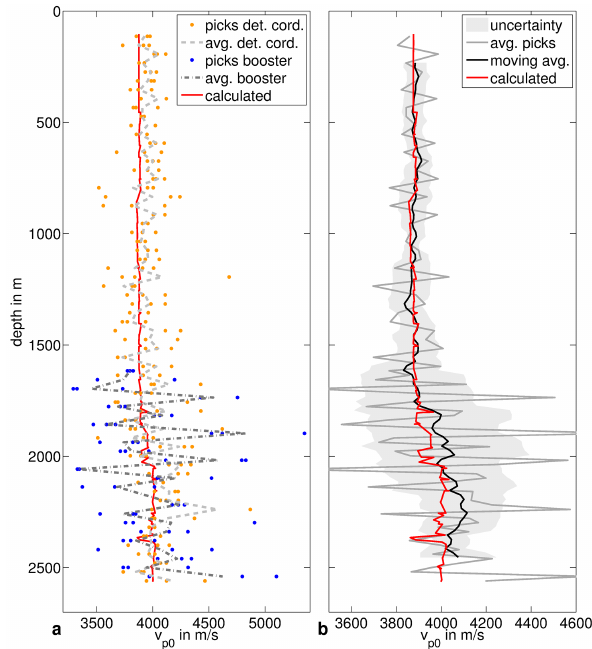
Figure 6. (a) The picked interval velocities for first break, maxi- mum and zero crossing picked from the detonation cord survey (or- ange dots) and the booster survey (blue dots) with the correspond- ing average, dashed light-grey line (detonation cord) and dashed- dotted line (booster). (b) Average interval velocity (grey line) de- rived from the travel times of the detonation cord and booster survey for the three different picks (first break, maximum, zero crossing). The black line shows the moving average with a sliding window of 200m and its rms error (grey area). These interval velocities are temperature-corrected to − 16 ◦ C. The red line in both subfigures shows the v p0 interval velocity calculated from the COF eigenval- ues of the EDML ice core as given in Fig.